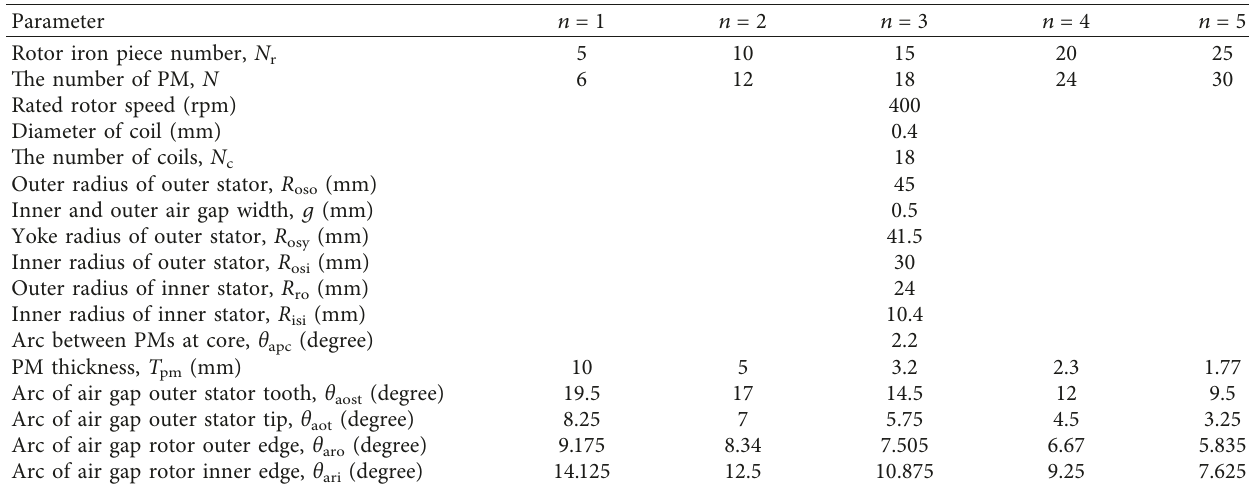
Figure 1: (a) Cross section of three-phase PS-DSPG with 6/5 and 18/15 (stator/rotor) poles. (b) Parameter design of the proposed PS-DSPG Table 1: The design parameters of 6 n /5 n -pole PS-DSPG structure.